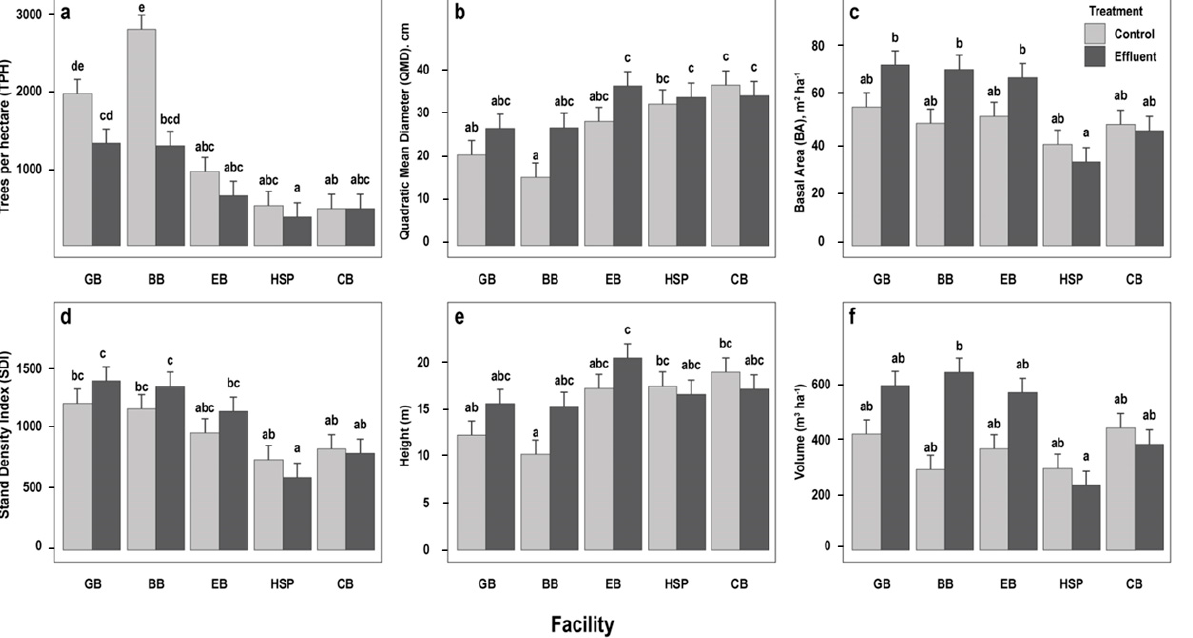
Figure 2. Stand parameter plot means and standard errors ( n = 5) at the water reuse facilities; ( a ) trees per hectare (TPH); ( b ) quadratic mean diameter (QMD); ( c ) basal area(BA); ( d ) stand density index (SDI); and ( e ) height; and ( f ) total volume. Five facilities included: Garfield Bay (GB), Bottle Bay (BB), Ellisport Bay (EB), Heyburn State Park (HSP) and Cave Bay (CB). Same letters over bars indicate no differences between treatment levels at α = 0.10. Facilities are arranged in establishment order with GB being first (1978) and CB last